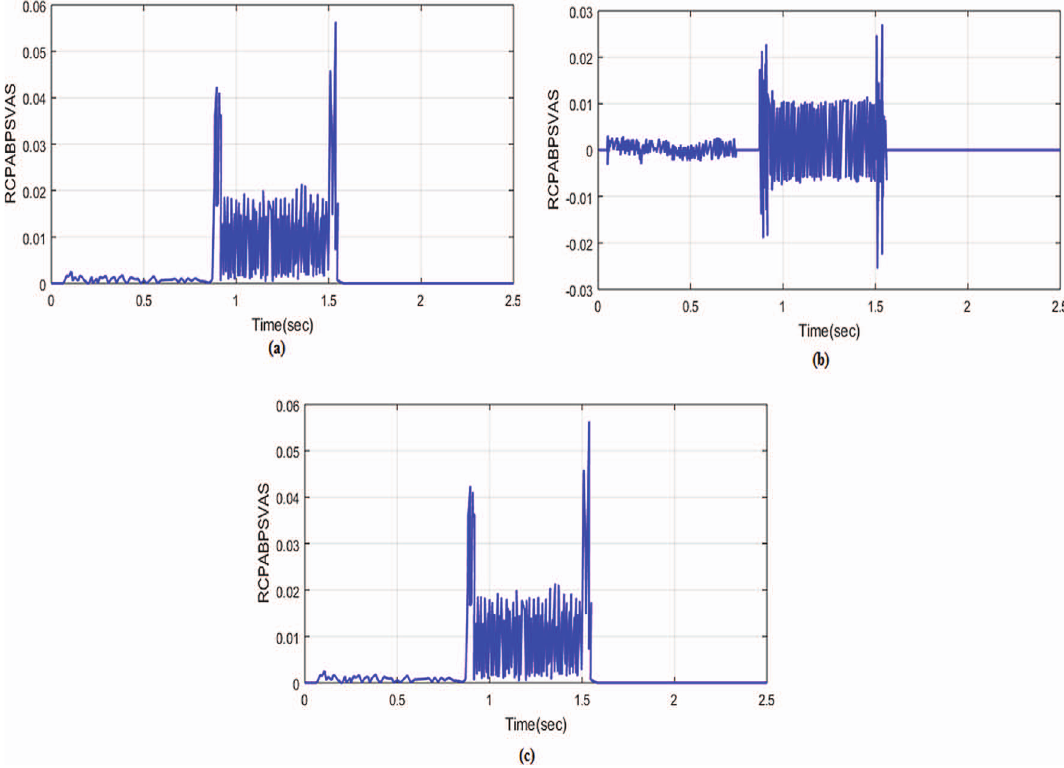
Fig. 14. System performance during Inductive load switching.